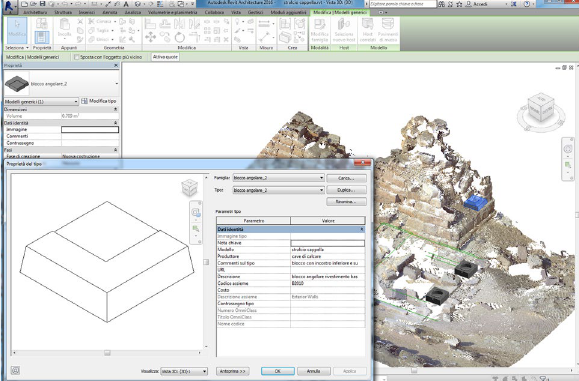
Figure 6: An example of family: an angular block and its description.